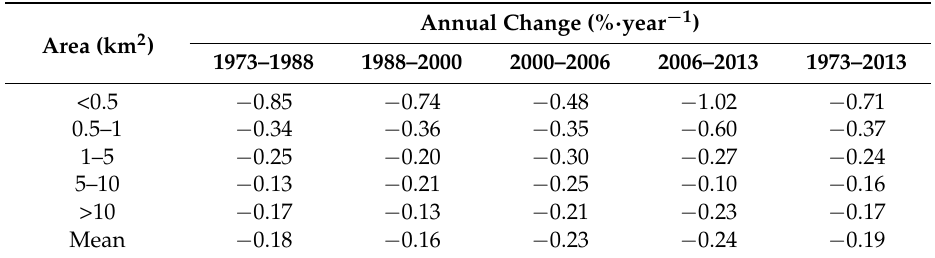
Table 3. Changes in glaciers of different area grades in the Geladandong Peak region from